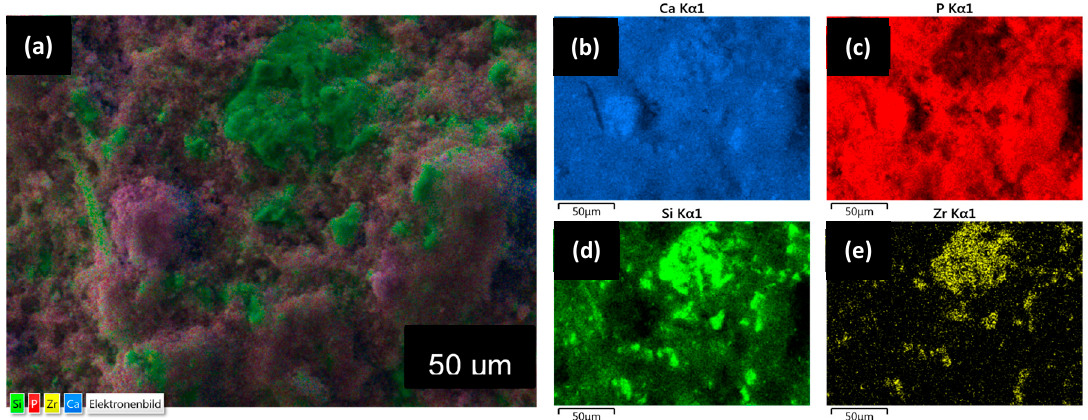
Figure 4. ( a ) Elemental mapping overlay image for BCB50; and distribution mapping of ( b ) calcium, ( c ) phosphorus, ( d ) silicon, and ( e ) zirconium within the BCB50 cement microstructure determined by EDX analysis.